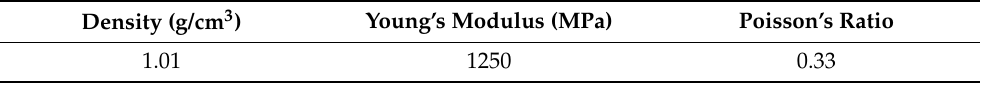
Figure 2. Various sample printed in this study: ( a ) Diamond 2 × 2 × 4; ( b ) Diamond 2 × 2 × 8; ( c ) Diamond 2 × 2 × 16; ( d ) Neovius 2 × 2 × 4; ( e ) Neovius 2 × 2 × 8; ( f ) Neovius 2 × 2 × 16; ( g ) Schwarz-P 2 × 2 × 4; ( h ) Schwarz-P 2 × 2 × 8; ( i ) Schwarz-P 2 × 2 × 16; ( j ) Gyroid 2 × 2 × 4; ( k ) Gyroid 2 × 2 × 8; ( l ) Gyroid 2 × 2 × 16. Table 2. PA 12 material